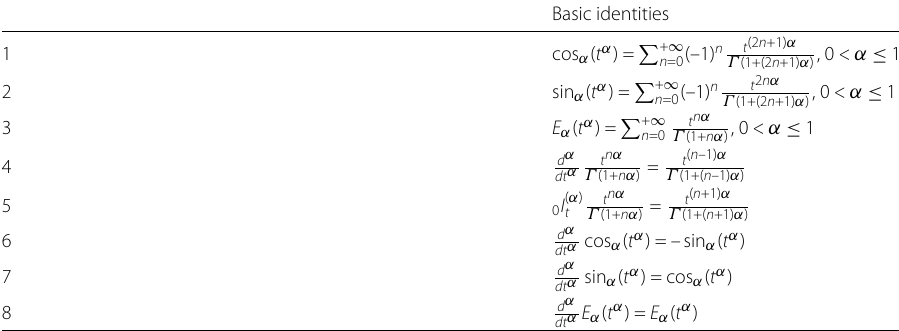
Table 1 Some useful identities of the local fractional calculus are give below